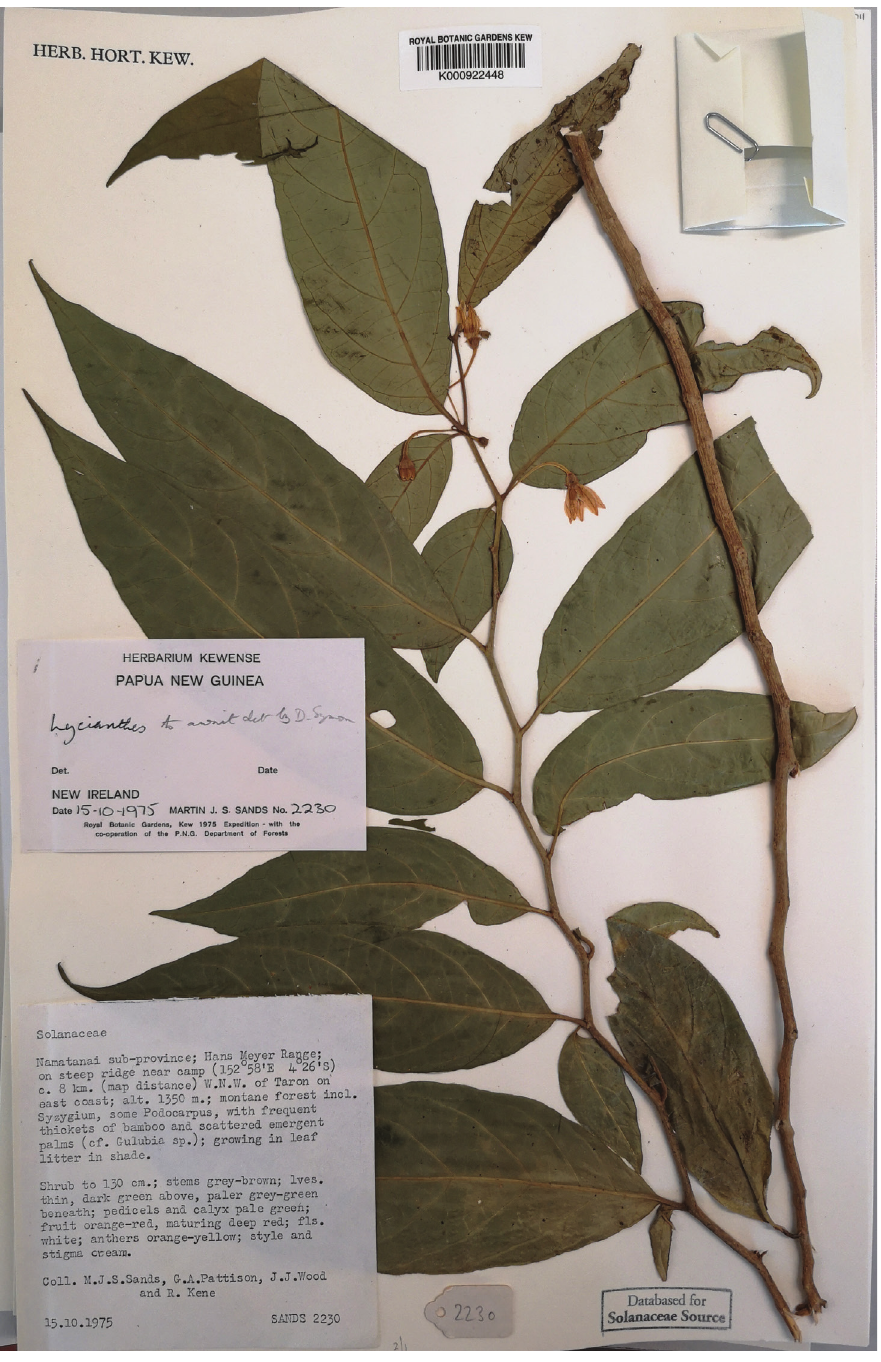
Figure 29. Lycianthes lucens herbarium specimen. Papua New Guinea. New Ireland: Sands et al. 2030 (K000922448). Courtesy of the Trustees of the Royal Botanic Garden, Kew, reproduced with